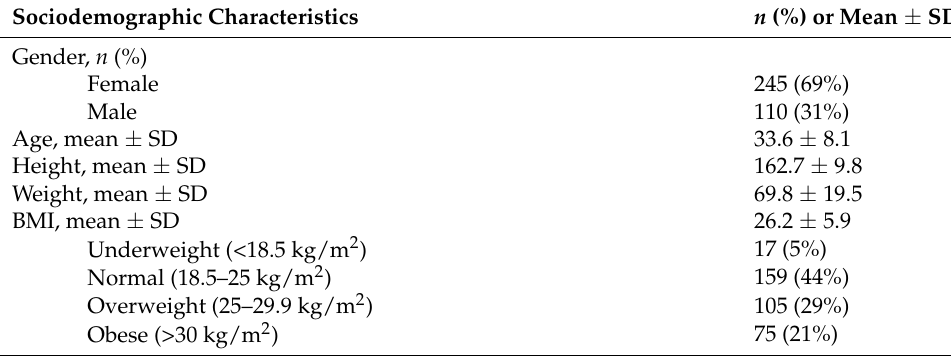
Table 1. Study Participants’ Characteristics n =